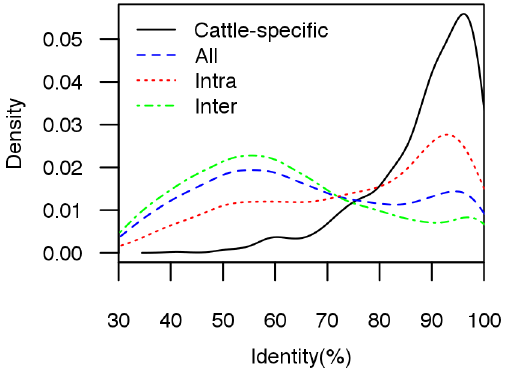
Figure 1. Distribution of sequence identity between duplicate gene